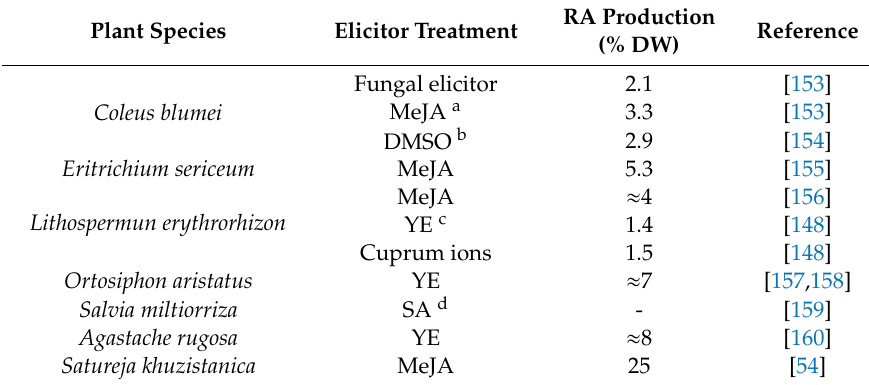
Table 3. Attempts to increase the biotechnological production of RA in cell suspensions by the use of elicitors and permeabilizing agents.